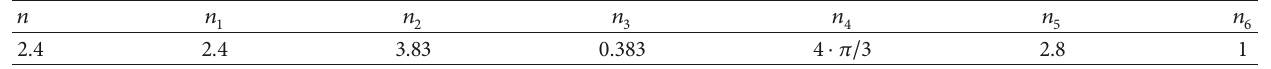
Table 1: Exponents used in the proposed method.